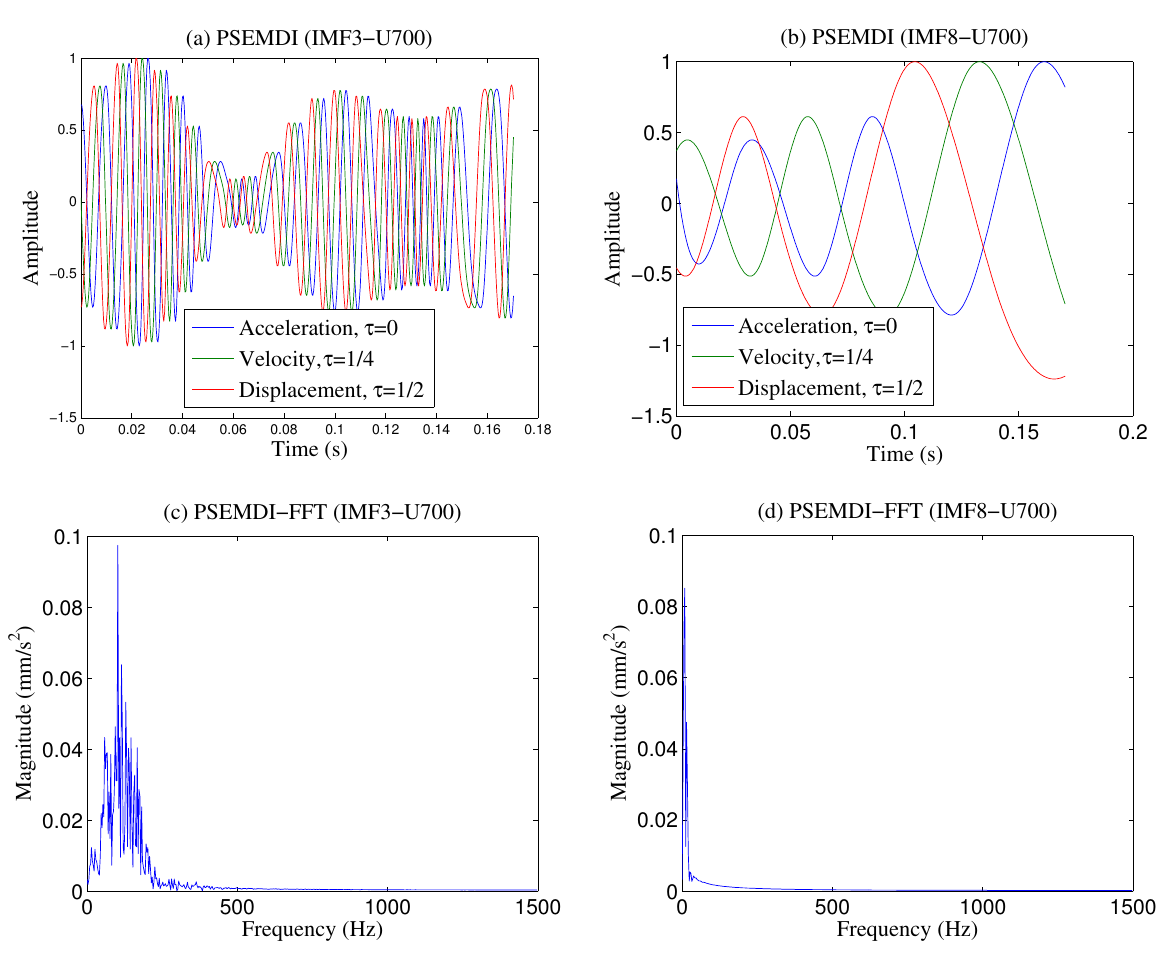
Figure 11. The phase shift property applied on two IMFs (Case 1, 700 rpm): ( a ) IMF 3; ( b ) IMF 8; their fundamental FFT frequency and its amplitudes are ( c , d ), respectively. The phase shift are 1/4 of the fundamental frequency for velocity and displacement,